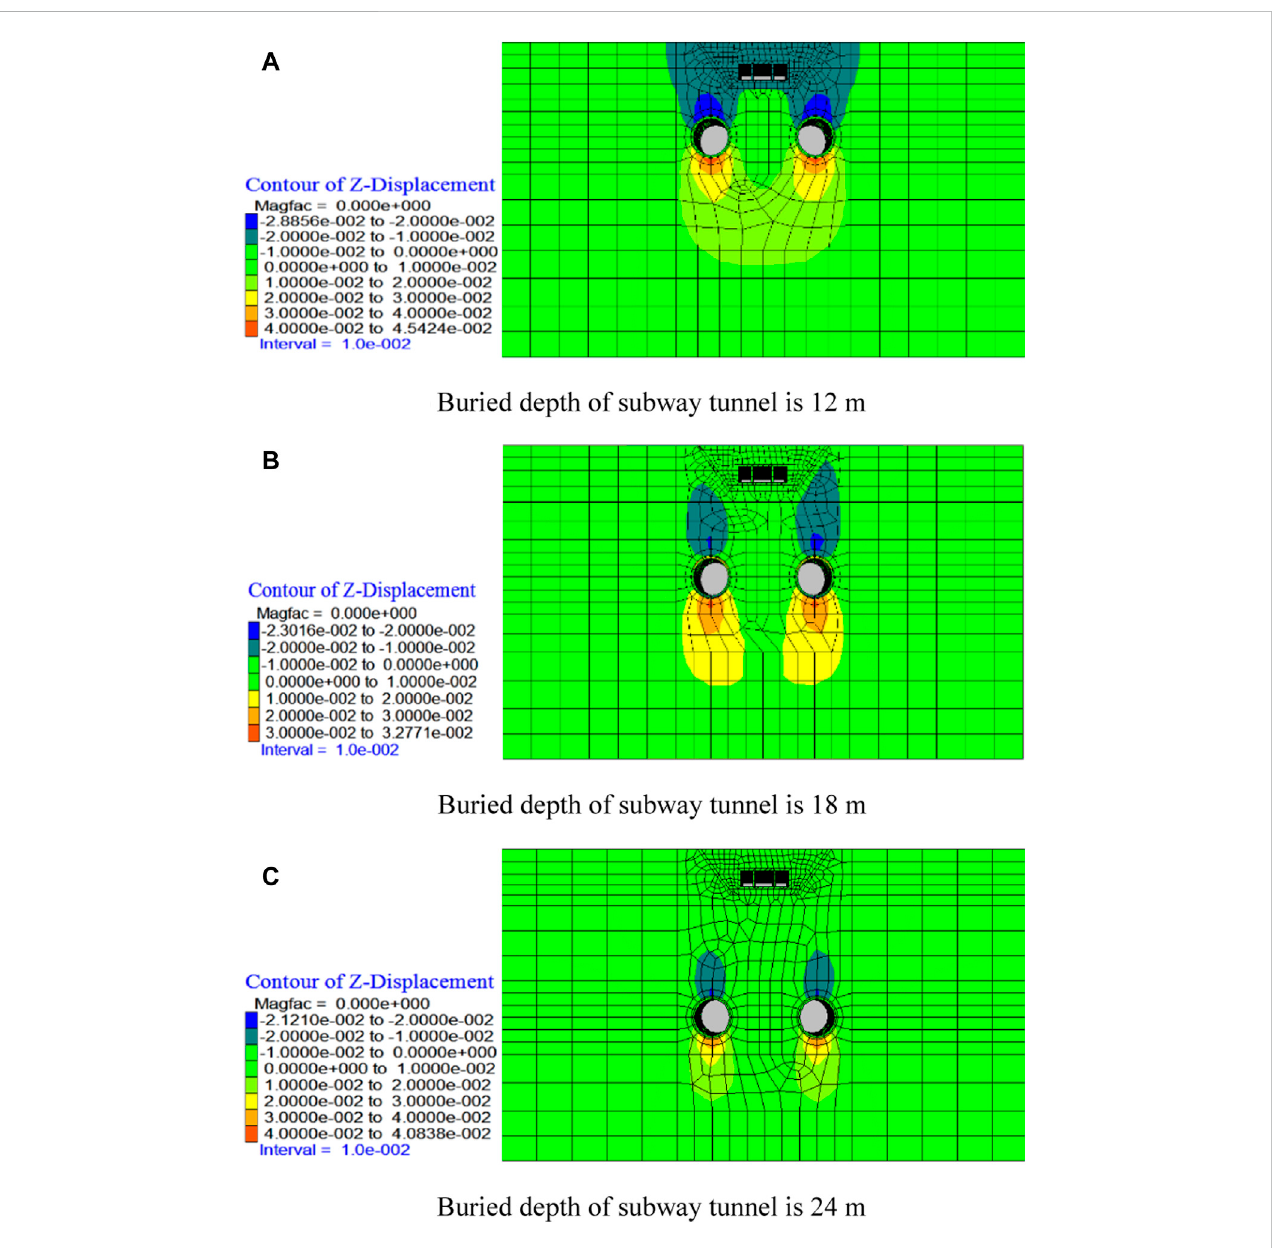
FIGURE 6 Vertical displacement diagram under different tunnel burial depths (unit: